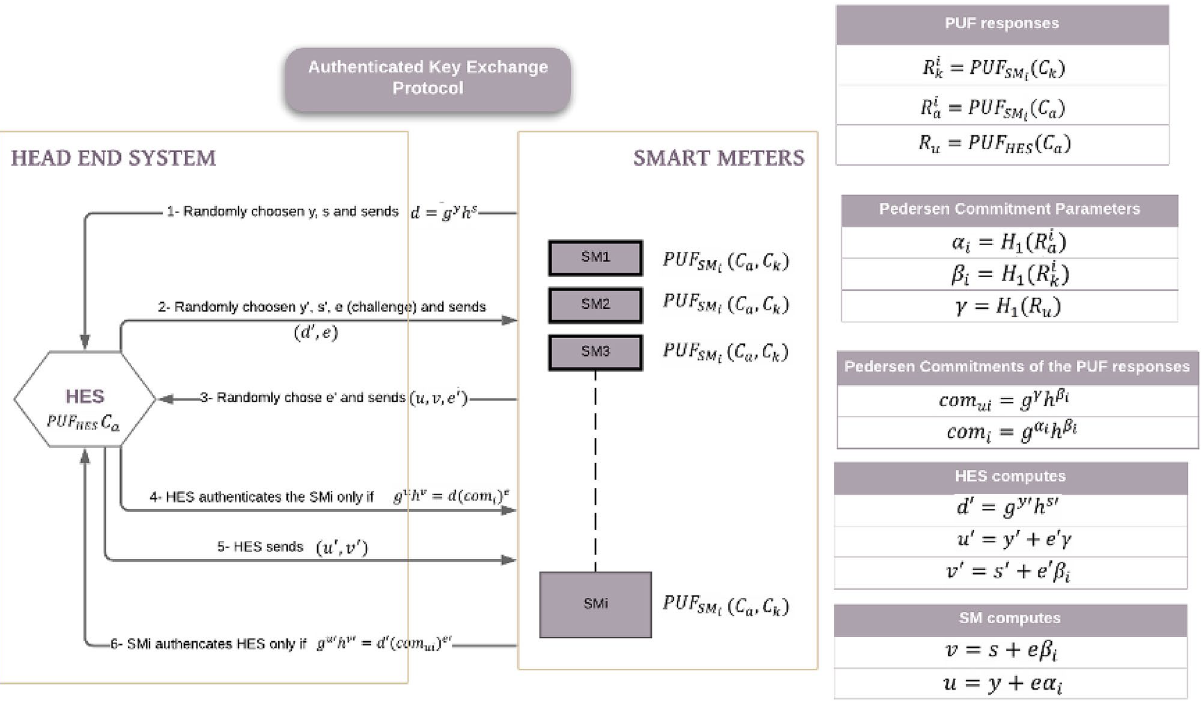
Figure 12. Authenticated Key Exchange Protocol